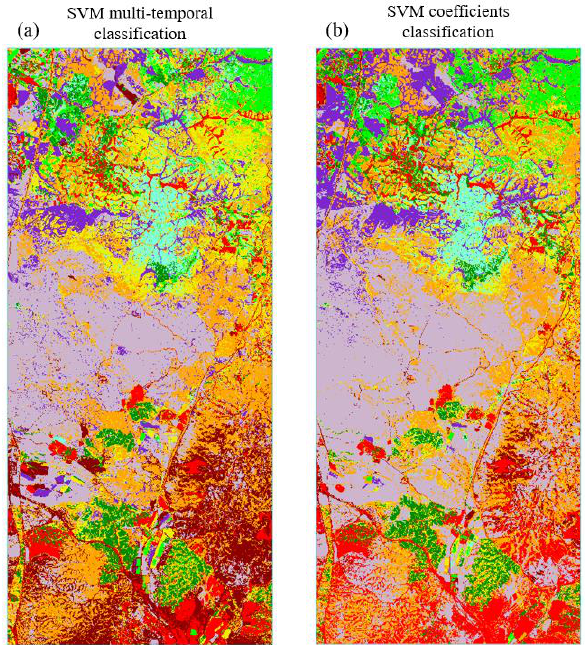
Figure 4: Results of SVM supervised classification: (a) SVM multi-temporal classification; (b) SVM classification of linear regression coefficients.